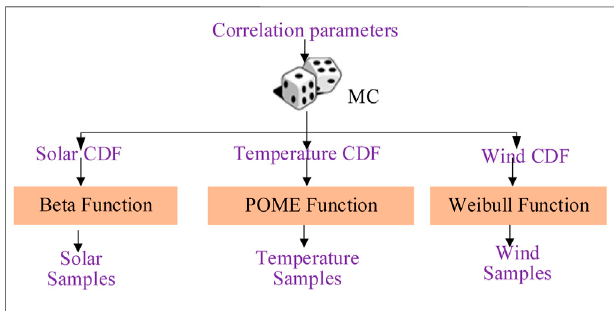
FIGURE 3 | Flow chart of weather